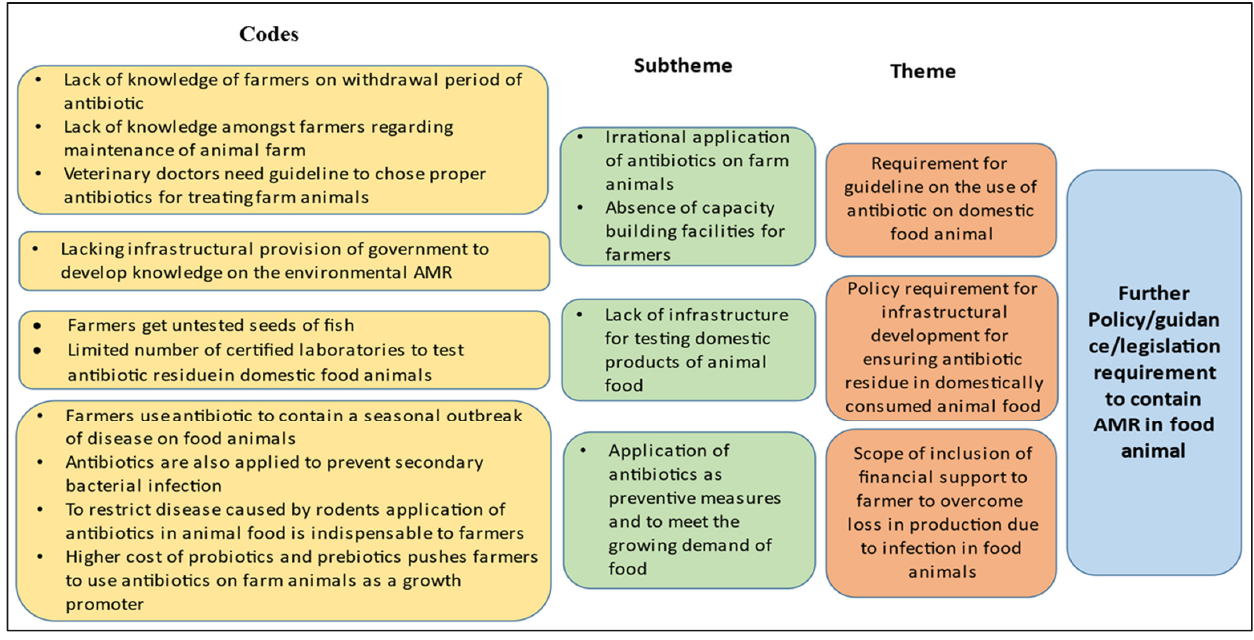
Figure 2. Thematic areas for intervention identified through KIIs in animal health sector for contain- ment of AMR.